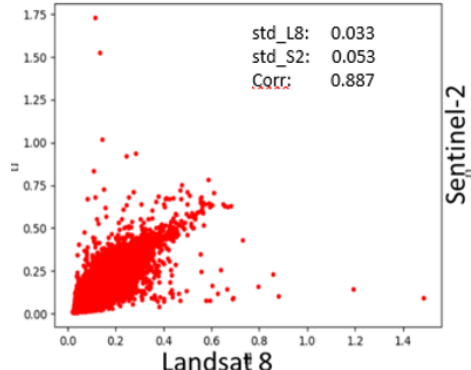
Figure 11. Scatterplot Landsat 8 and Sentinel-2 corrected with iCOR, images of both sensors for Figure 9. Landsat 8 & Sentinel-2 reflectance values difference with iCOR.